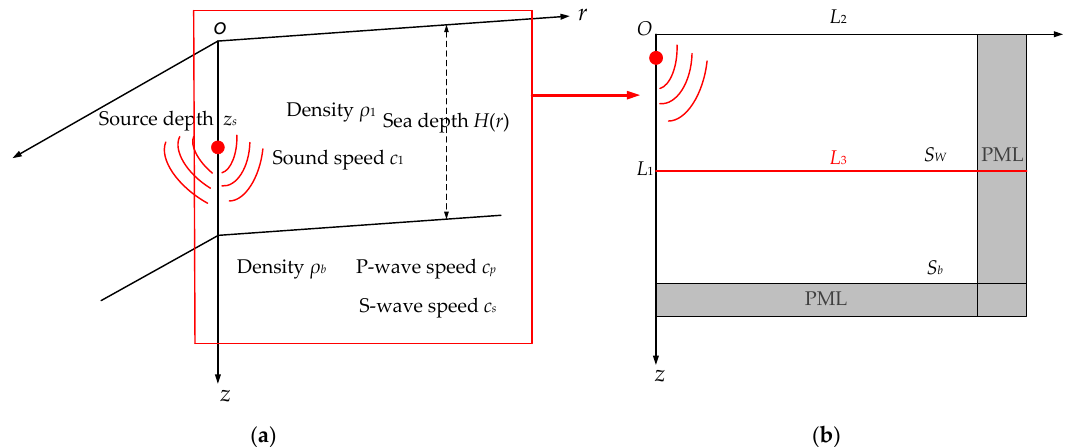
Figure 1. The full waveguide model unifies the sea water and the sea bottom in shallow water. ( a ) The waveguide model in three-dimensional cylindrical coordinates; ( b ) the solution region in the ( r , z ) plane.